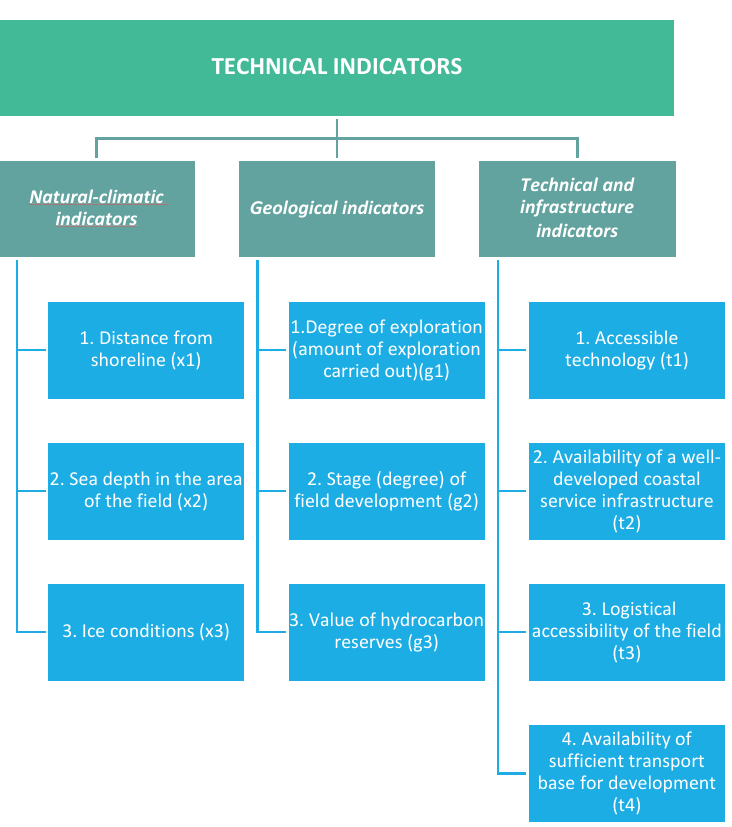
Figure 3. Classification of technical indicators for assessing the technical and economic potential of developing Arctic offshore oil and gas fields. (Compiled by the authors).